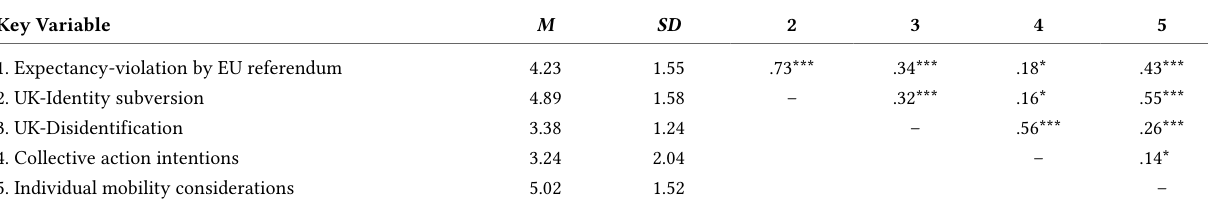
Descriptive Statistics and Intercorrelations for Key Variables